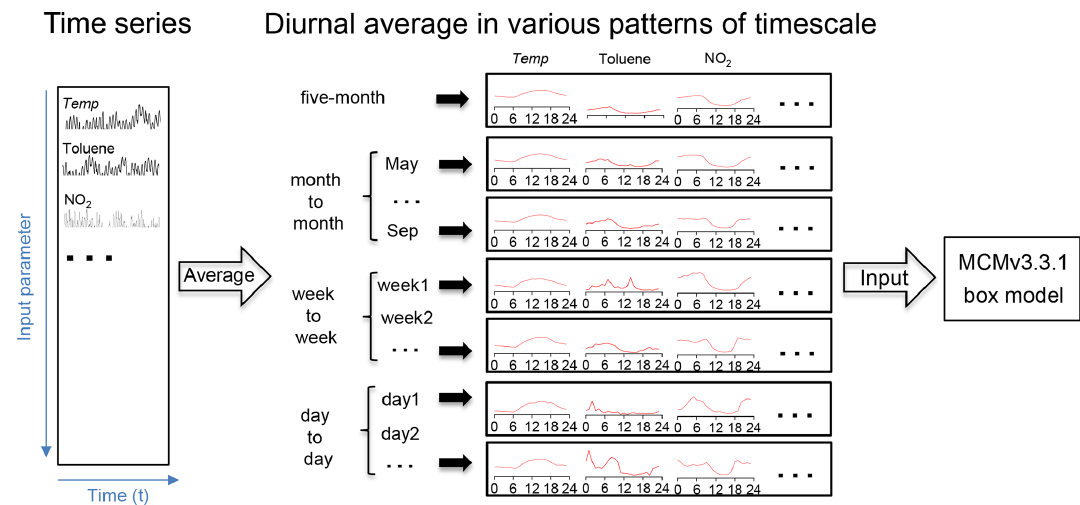
Figure 1. Schematic diagram of the dataset treatment to derive four patterns of timescale for 0-D box model input. Note that the four patterns (i.e., 5-month, monthly, weekly, and daily) were the diurnal average of the initial dataset. This diagram takes one site and several input measurements (temperature, toluene, and NO 2 ) as